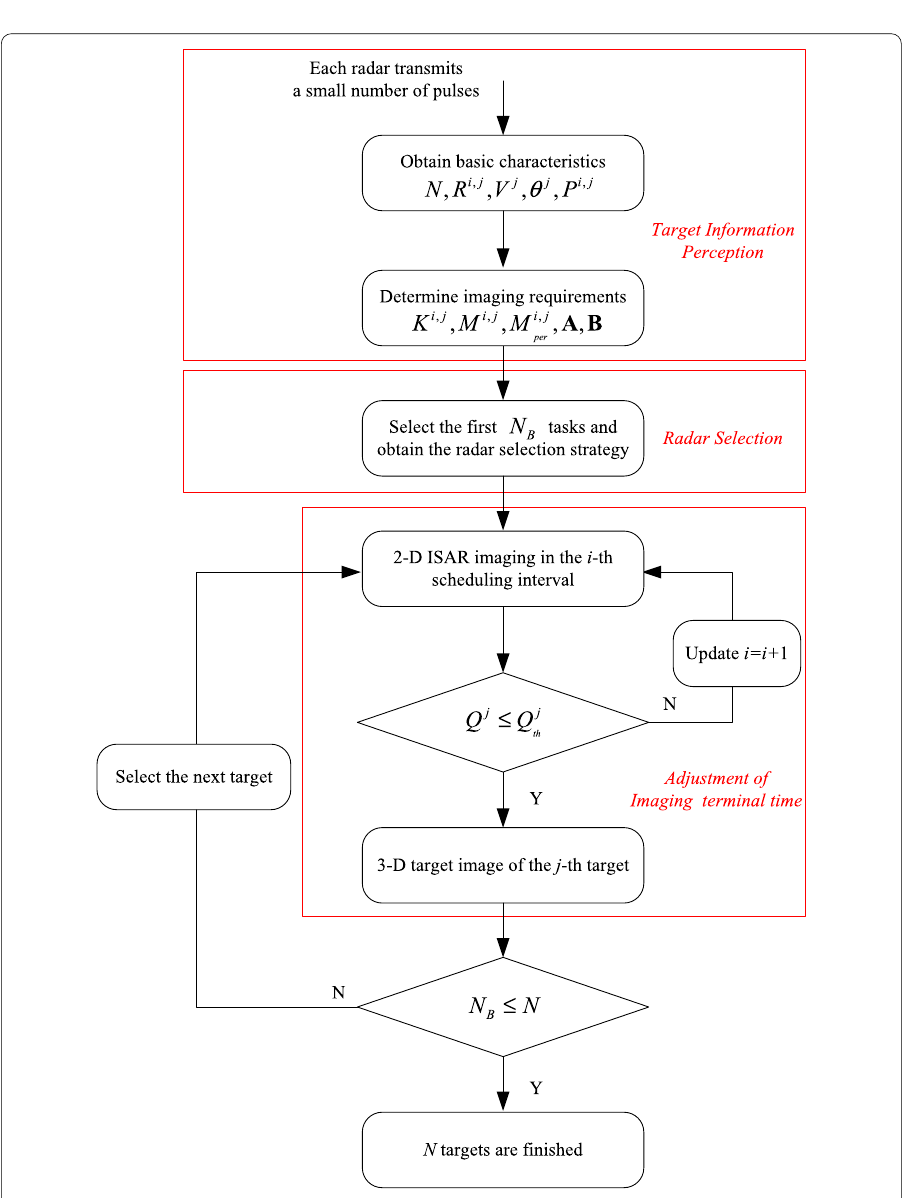
Fig. 7 The detailed framework of adaptive task scheduling